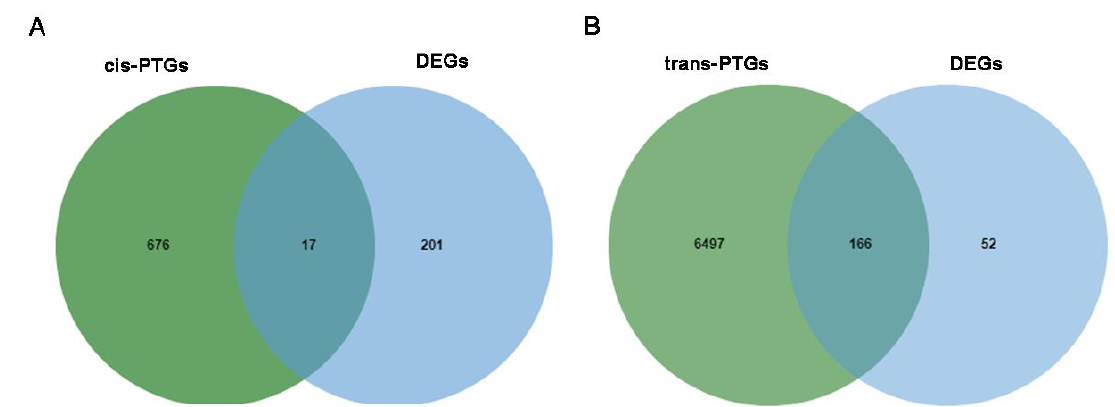
Figure 2. ( A ) The cis-regulated PTGs of lncRNAs that were differentially expressed between the two groups; 17 co-expressed genes from the DEGs and DE lncRNA target genes are shown. ( B ) The trans-regulated PTG differences between the two groups; 166 co-expressed genes from the DEGs and DE lncRNA target genes are shown.